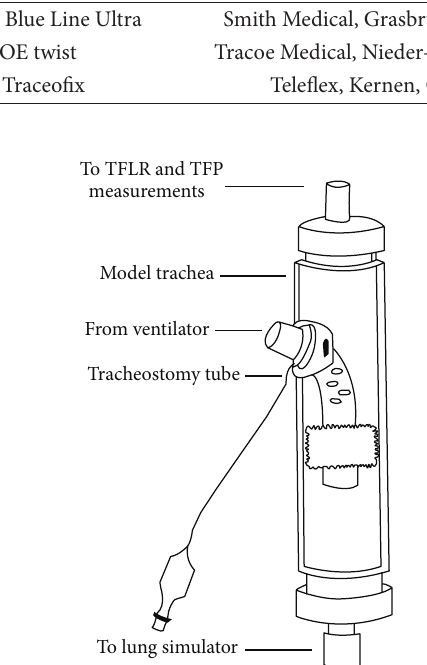
Figure 1: Schematic drawing of tracheostomy simulator with a fen- estrated tracheostomy tube sited. TFLR: transfenestration leakage rate; TFP: transfenestration pressure.